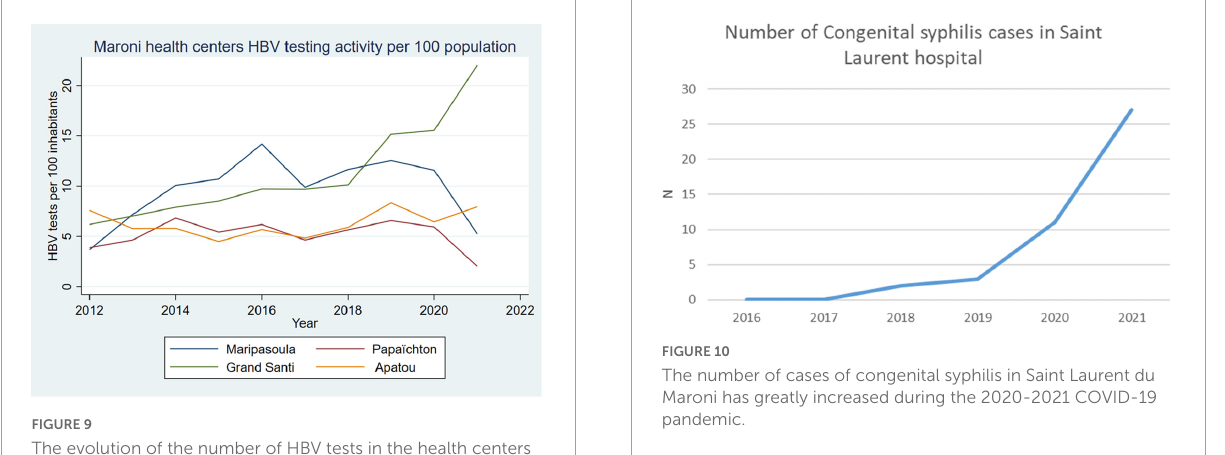
FIGURE10 The number of cases of congenital syphilis in Saint Laurent du Maroni has greatly increased during the 2020-2021 COVID-19